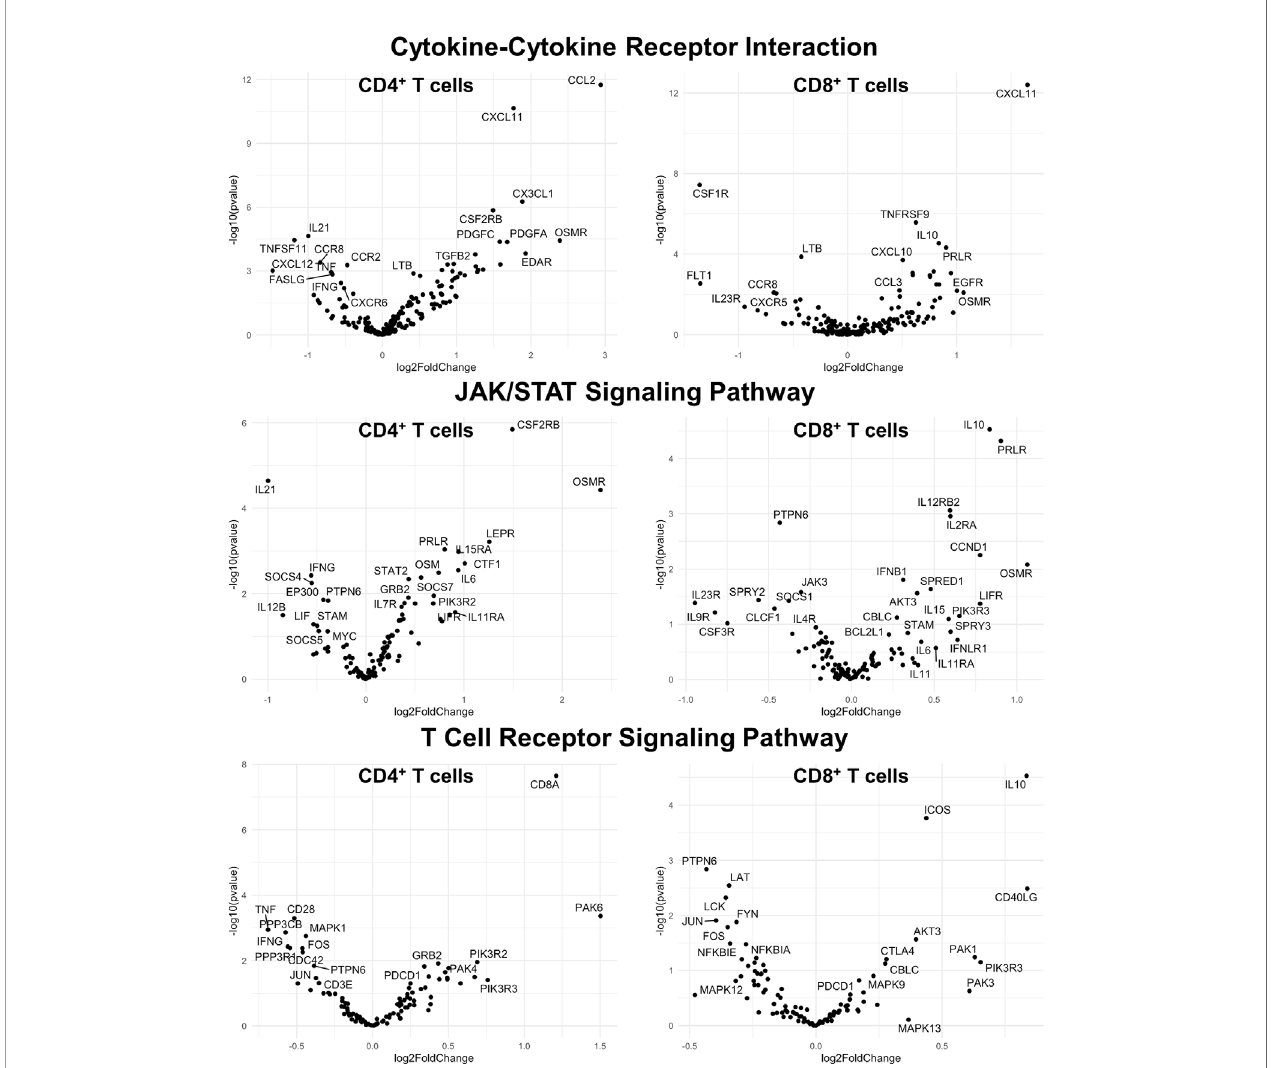
FIGURE 9 | Genes related to cytokine-cytokine receptor interaction, JAK/STAT signaling, and T cell receptor signaling are differentially expressed in CD4 + and CD8 + T cells from the CNS of microglia-de fi cient SJL mice compared to microglia-competent SJL mice. SJL/J mice were treated with a PLX5622-supplemented or control diet seven days prior to i.c. TMEV infection and sacri fi ced at 6 DPI for analysis (n = 10 mice per group). Volcano plots of RNA-seq transcriptome data displaying gene expression within the indicated KEGG pathways of enriched CD4 + and CD8 + T cells from the CNS of microglia-de fi cient SJL/J mice relative to microglia- competent SJL/J